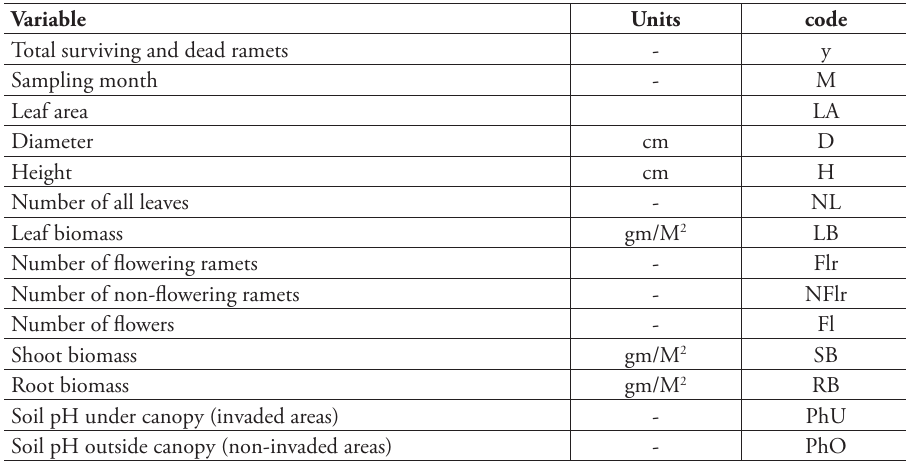
Table 1. List of measured variables from which the average values were taken from 10 plants per stand in each of the three urban habitats (Canal banks, Wastelands and